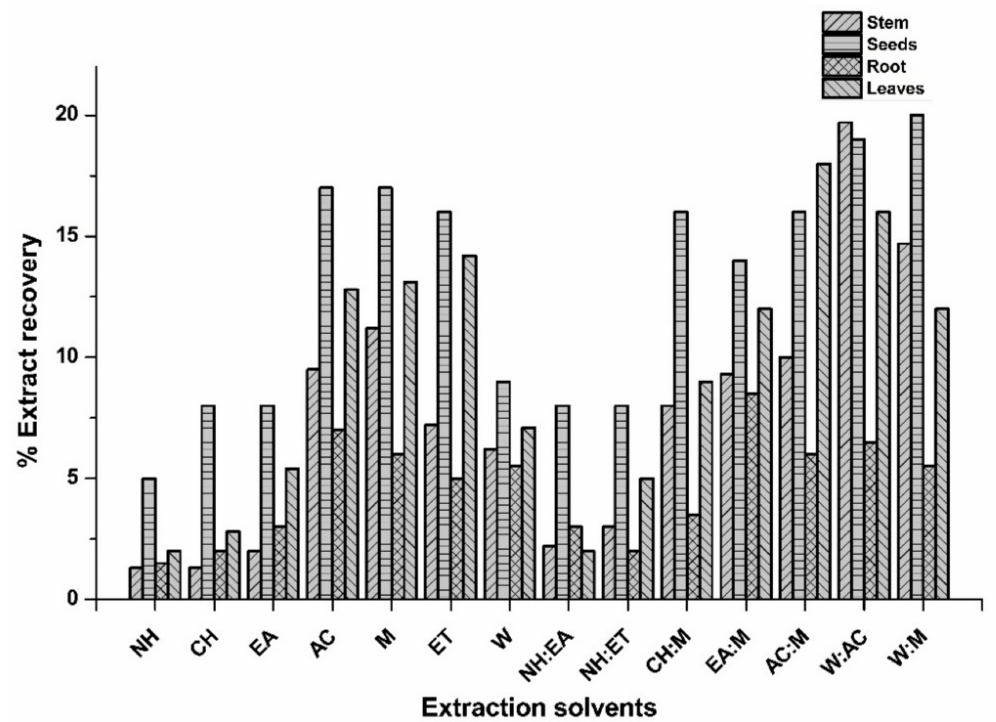
Figure 1. Percent extract recovery of stem, root, seeds, and leaves of P. glabrum using various individual solvents and their combination (1:1) for extraction. NH: n -hexane; CH: Chloro- form; AC: Acetone; EA: Ethyl acetate; M: Methanol; ET: Ethanol; W: Distilled water; NH:EA: n -hexane + Ethyl acetate; NH:ET: n -hexane + Ethanol; CH:M: Chloroform + Methanol; EA:M: Ethyl acetate + Methanol; AC:M: Acetone + Methanol; W:AC: Distilled water + Acetone; W:M: Distilled water +